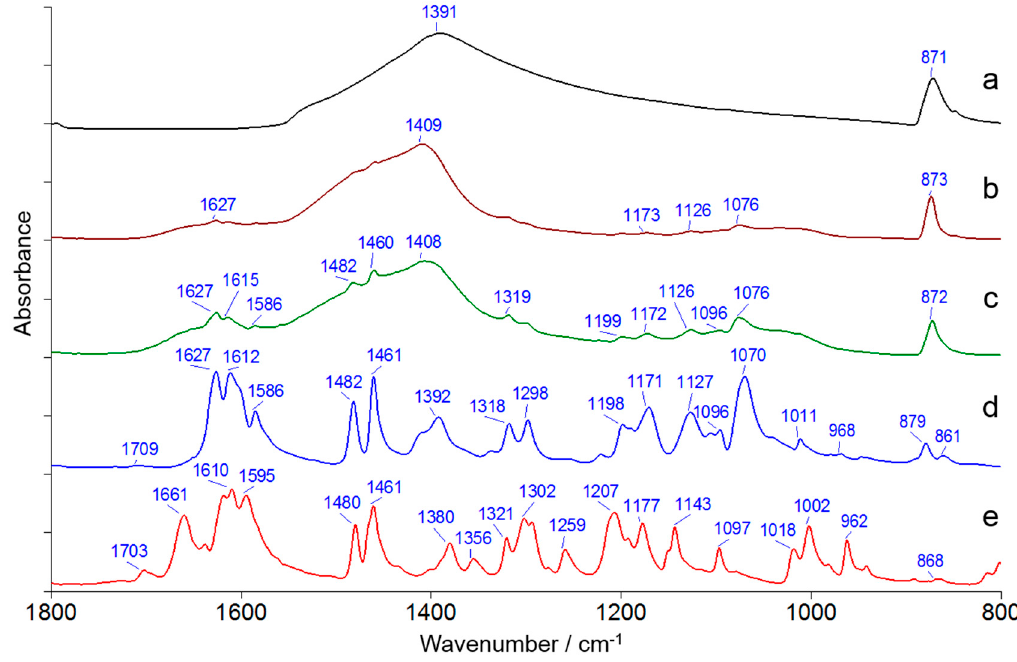
Figure 2. ATR-FTIR spectra of Indigo Naturalis and reference compounds. (a) CaCO 3 (calcite);